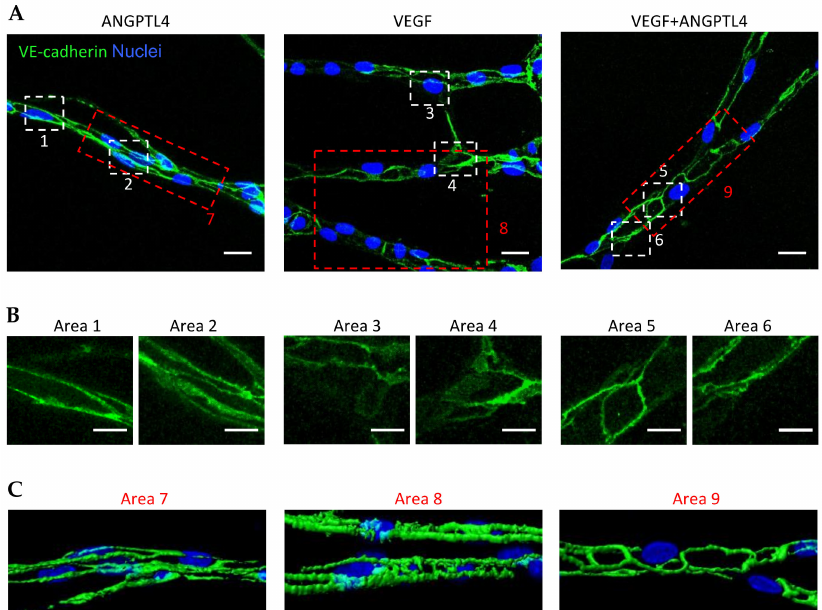
Figure 2. Regulation of VE-cadherin pattern in sprouting capillaries by ANGPTL4. ( A ) Z-stack projection of sprouting capillaries after 4 days of culture with ANGPTL4 (2.5 µ g/mL) and/or VEGF (2.5 ng/mL). Capillaries were stained for VE-cadherin (green) and nuclei (blue). Scale bar: 20 µ m. White boxed areas are presented in ( B ). Scale bar: 10 µ m. ( C ) 3D reconstruction of capillaries presented in red boxed images. These images are representative of three independent